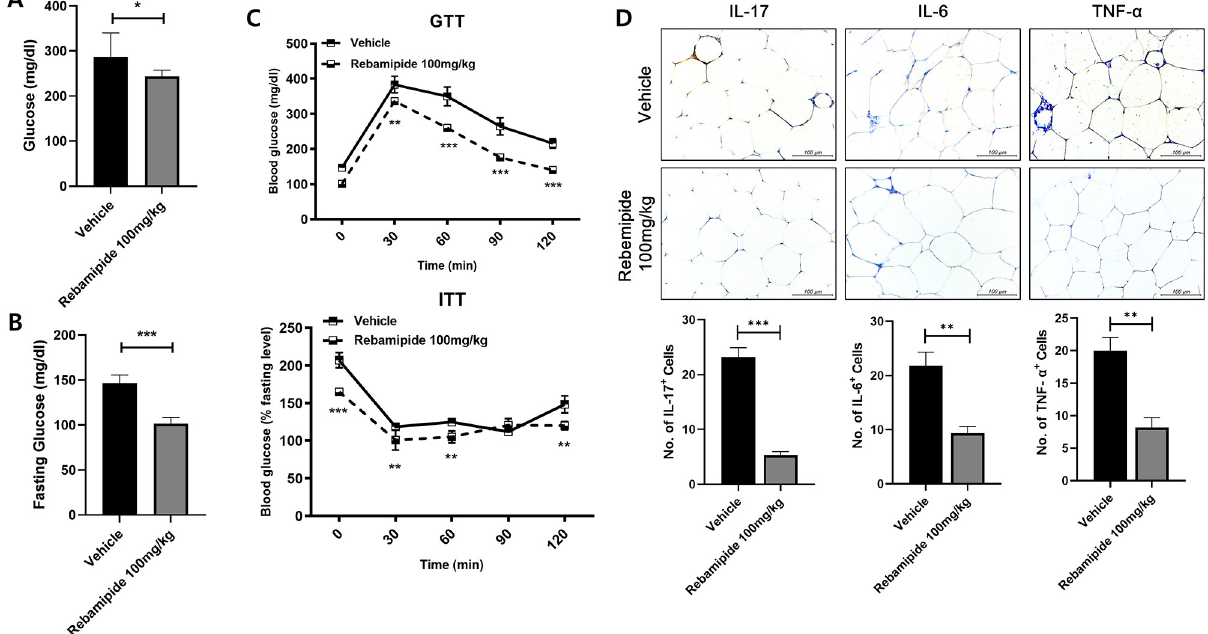
Fig 2. Rebamipide reduced blood glucose and inflammatory cytokines levels in mice. (A) Total blood glucose levels and (B) fasting glucose levels in treatment and control mice. (C) Glucose tolerance test (GTT) and insulin tolerance test (ITT) in fasted and non-fasted mice, respectively. (D) The immunohistochemistry images showed the expression of IL-17, IL-6 and TNF- α which were pro-inflammatory cytokines. � P < 0.05, �� P < 0.01 and ��� P < 0.005.